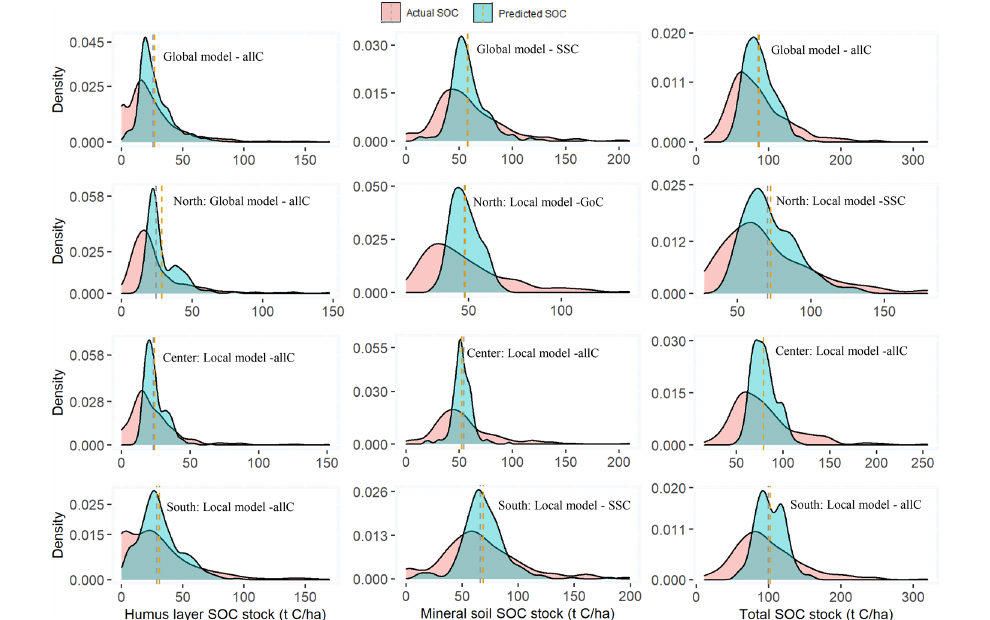
Figure 3. Density plots of the actual versus predicted humus layer, mineral soil, and total SOC stock from the local and global random forest models (with lowest root mean square errors). Line – average values; SSCs – site-specific covariates; GoCs – group of covariates; allCs – all covariates; dashed lines – mean of SOC